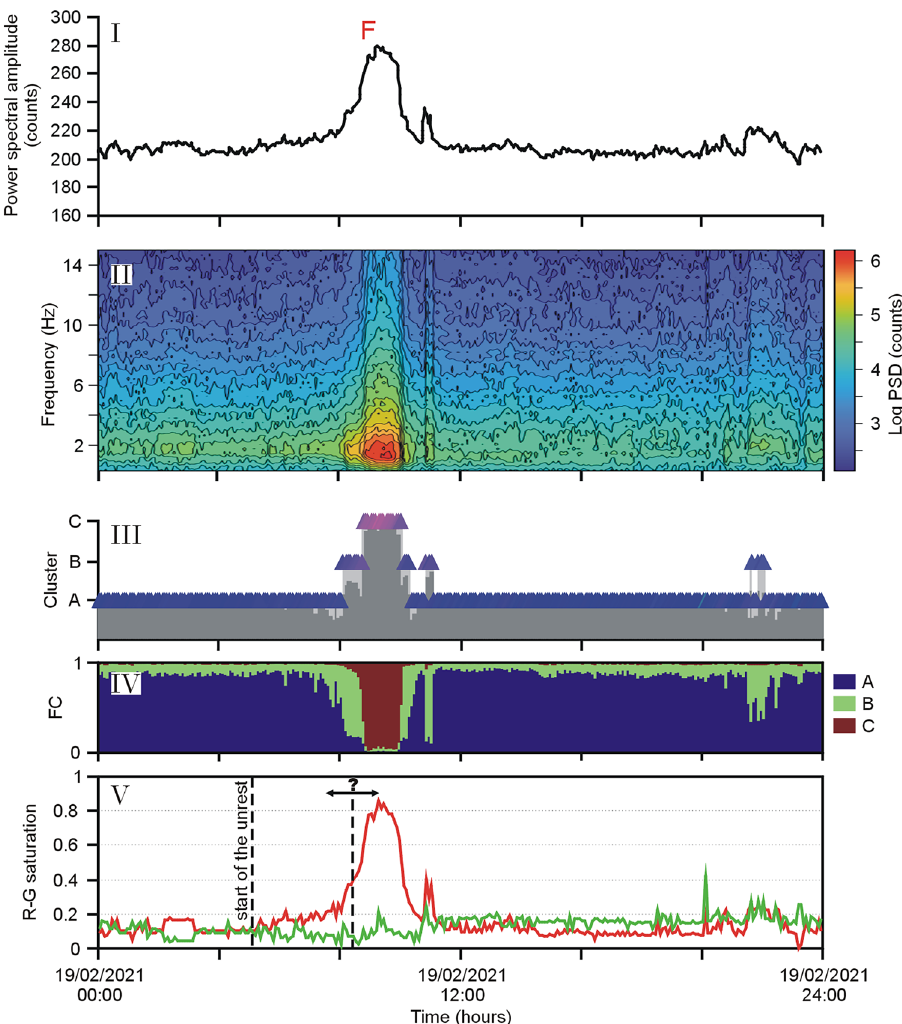
Figure 3. Episode of lava fountain (F) at Etna on February 19, 2021. Based on the analysis of volcanic tremor at the ESVO station, the diagrams cover 24 h: ( I ) spectral amplitude; ( II ) spectrogram; ( III ) results of the SOM in the form of colored triangles; ( IV ) fuzzy clustering (FC) considering three clusters; ( V ) normalized values of the saturation of the Red-Green (R-G) components in the SOM colors. The first dashed line marks the start of the unrest (warning flag of the multi-station system by Spampinato et al. 15 ). The second dashed line (with the question mark) refers to the possible range of transition to a paroxysmal